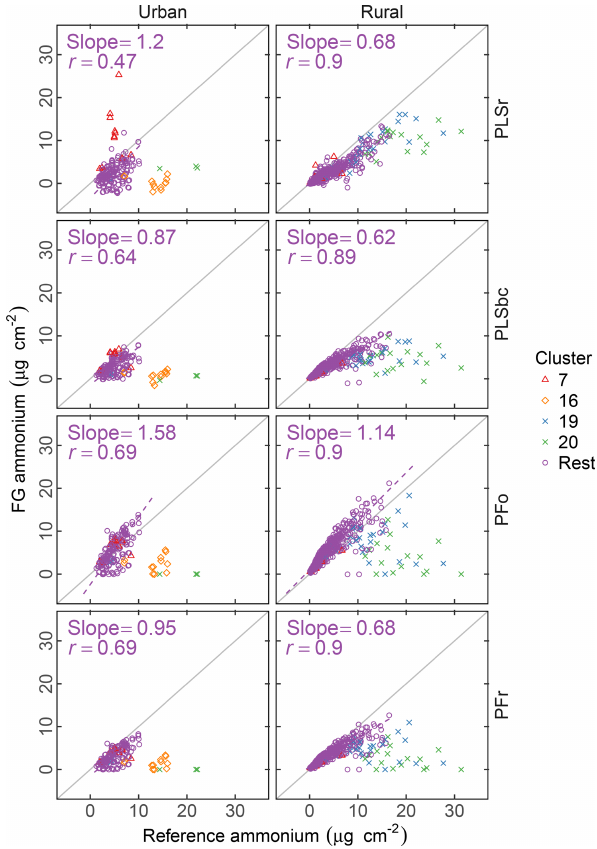
Figure 6. Comparison of estimated ammonium (FG ammonium) against ammonium measured using ion chromatography (IC ammo- nium). PFo refers to peak fitting using the original parameters. PLSr refers to partial least square using raw spectra. PFr refers to peak fit- ting using the recalibrated absorption coefficients. PLSbc refers to partial least square using baseline-corrected